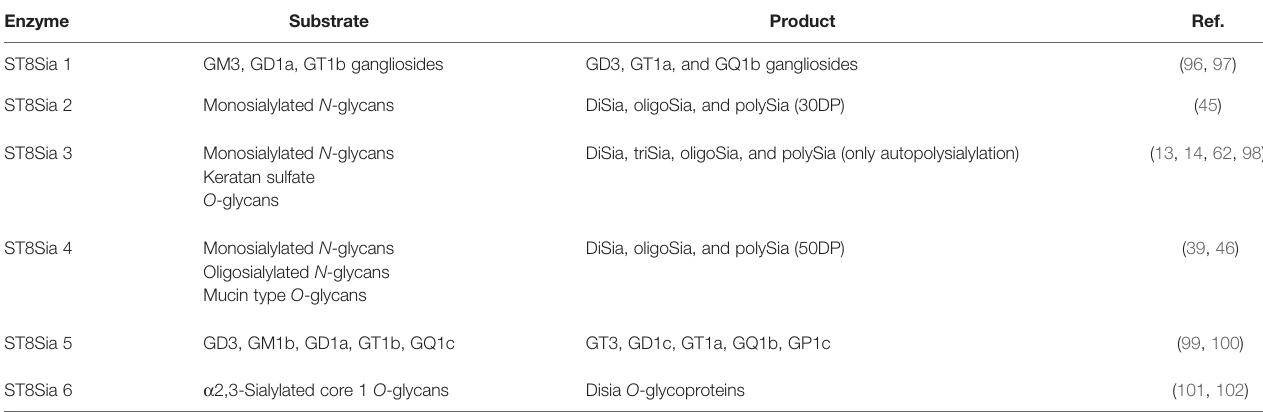
TABLE 2 | Preferred acceptor substrates and products for the human ST8Sia family. Enzyme